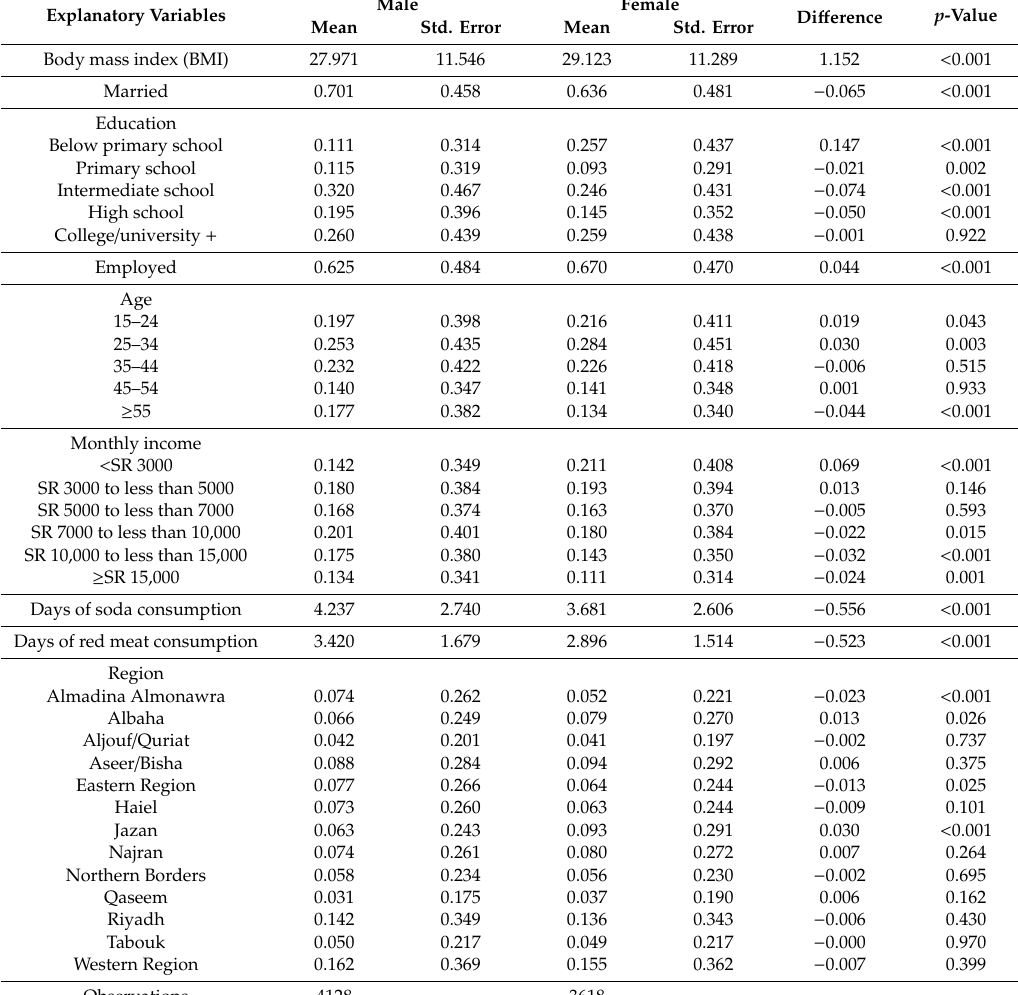
Table 1. Social and demographic characteristics. Results from the 2013 Saudi Health Interview Survey